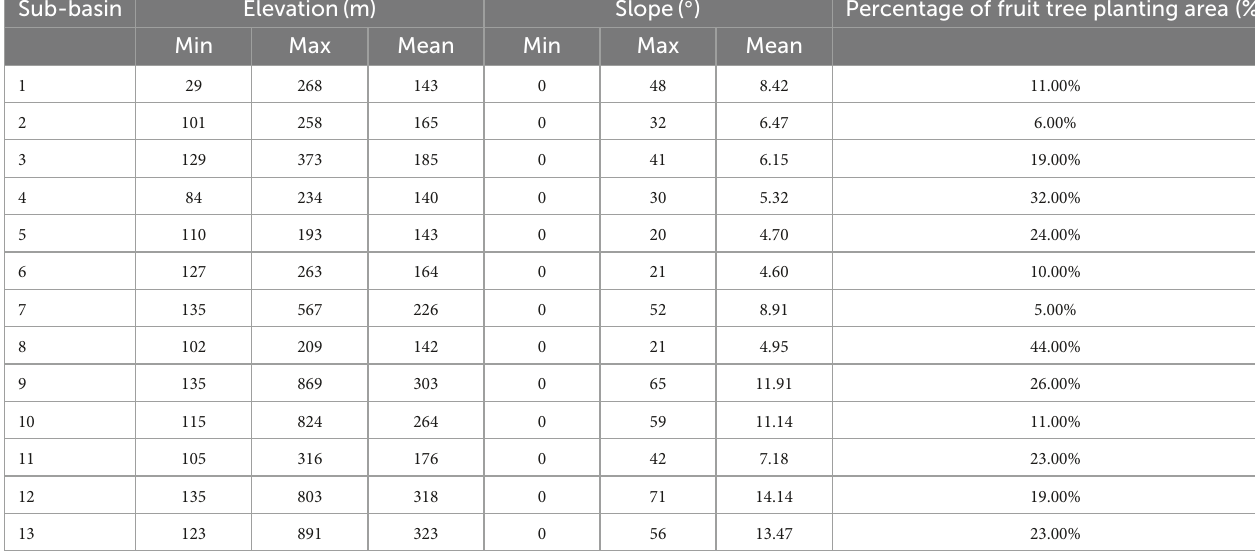
TABLE 7 Elevation, slope and percentage area of fruit tree planted in each sub-basin. Sub-basin Elevation (m) Slope ( ◦ ) Percentage of fruit tree planting area